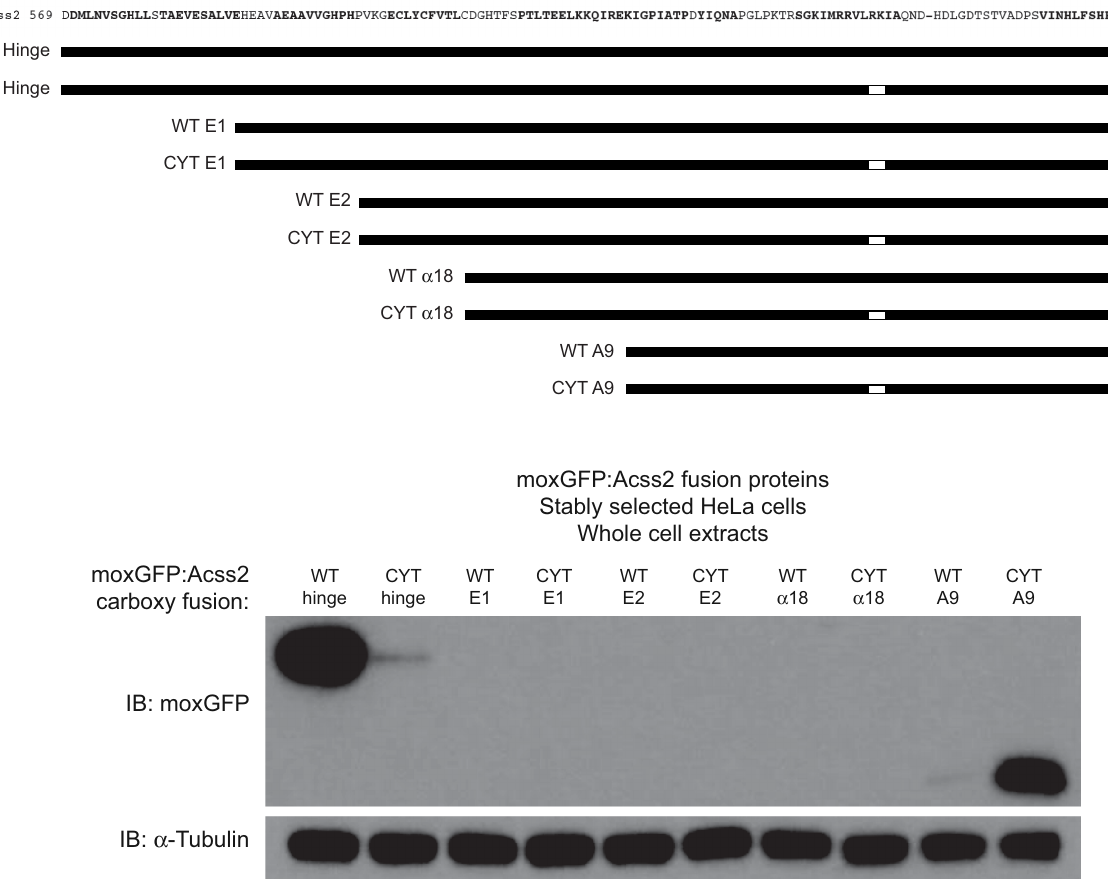
Fig 8. Truncating the Acss2 hinge region results in protein destabilization of a fusion protein. (A) Stable HeLa cell lines expressing amino terminal truncations of the WT or ED Acss2 carboxy terminal hinge region fused to the carboxy terminus of the green fluorescent protein moxGFP were generated by lentiviral transduction followed by drug selection. (B) Immunoblots for the moxGFP:Acss2 fusion proteins were performed to assess relative protein levels (normalized to protein amount and compared to immunoblot of α -tubulin).